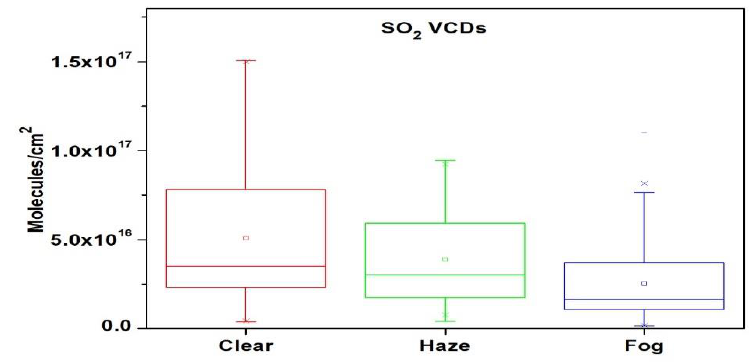
Figure 10. Boxplot for SO 2 VCDs during different conditions.